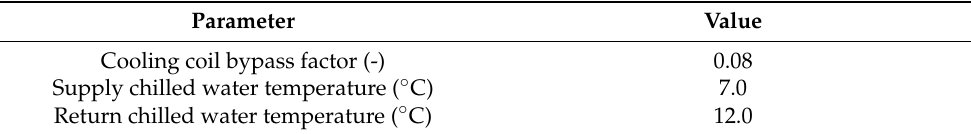
Table 8. Assumptions made for the conventional air handling unit.